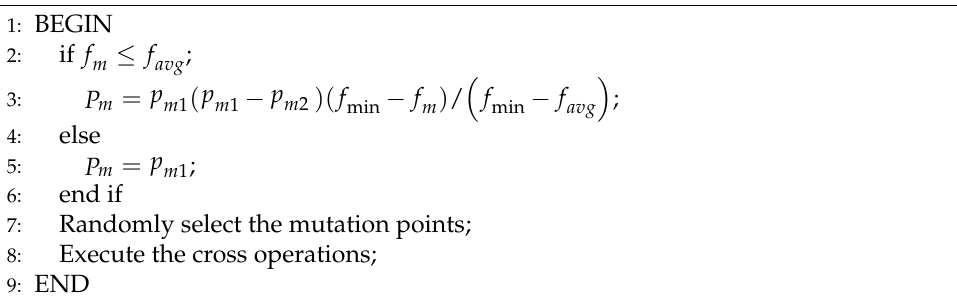
Figure 7. Single − point mutation operation of task offloading position. Algorithm 3 Offloading position single-point mutation